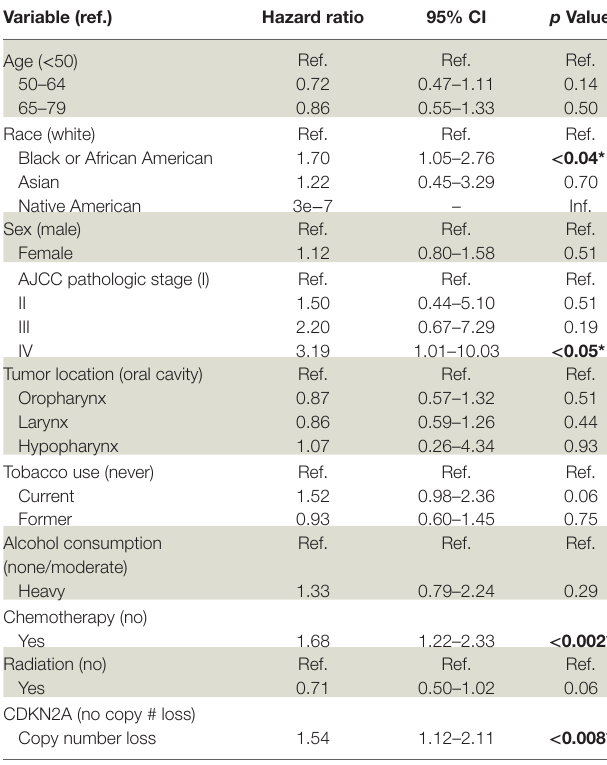
TaBle 2 | Univariable Cox proportional hazards analysis of all HPV-negative head and neck squamous cell carcinomas.